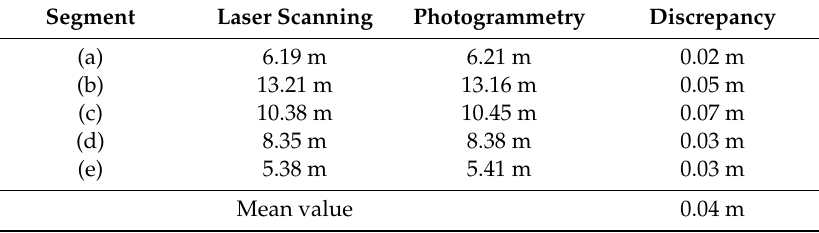
Figure 7. Laser scanning 3D point cloud of the test area including the segments ( a – e ). Green portion: The reference scale bar used to constrain the photogrammetric model; black lines: Distances used for validation. Table 2. The results obtained during metric validation of the obtained 3D models.